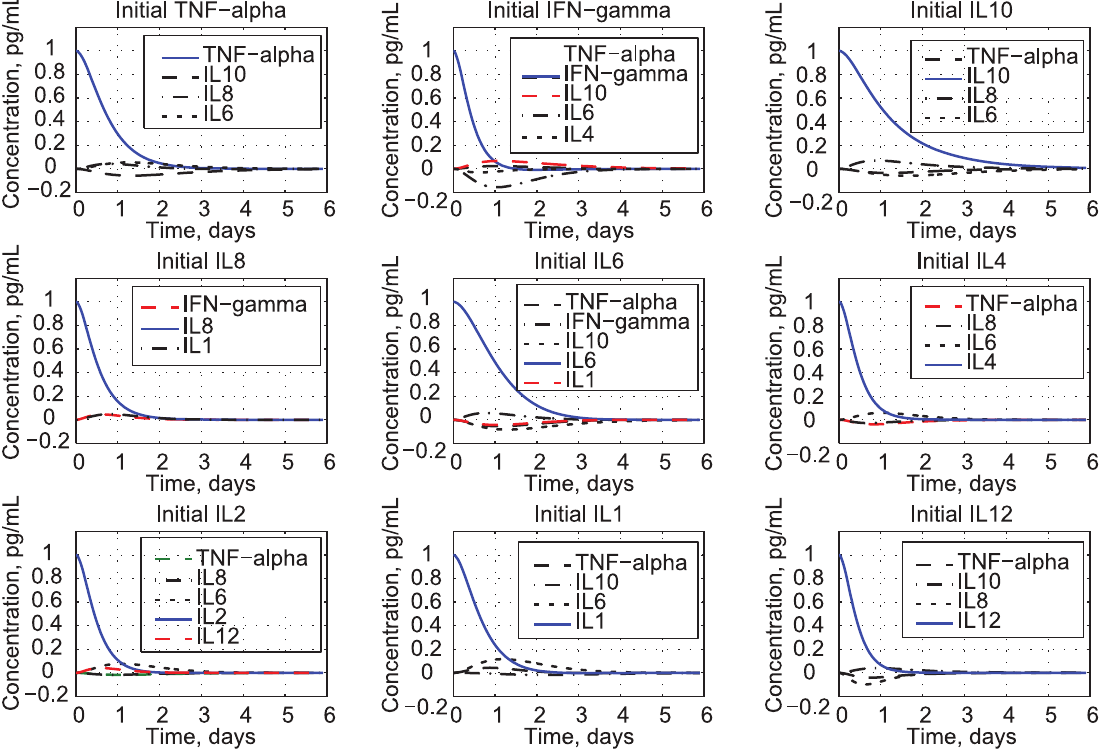
Figure 5. Unit initial-concentration response for nine cytokines based on the coupled.